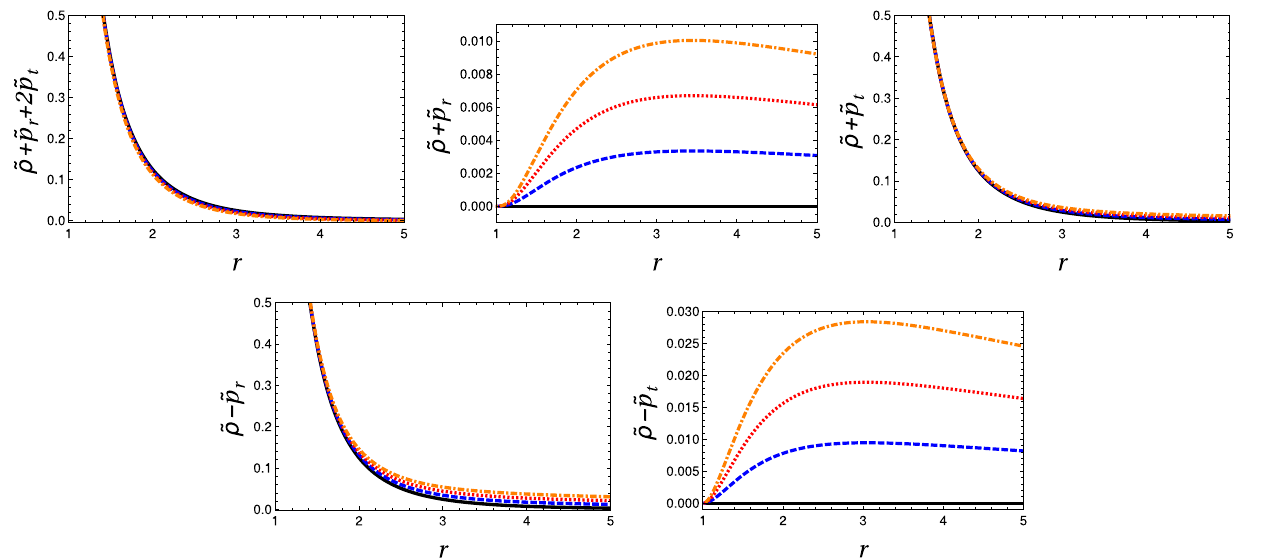
Fig. 3 The figures show the evolution of energy conditions versus the radial coordinate for the third model. We have added the RN case for comparison. To show the impact of the parameter α , we evaluate the functions for three different values of the anisotropic coupling α plus